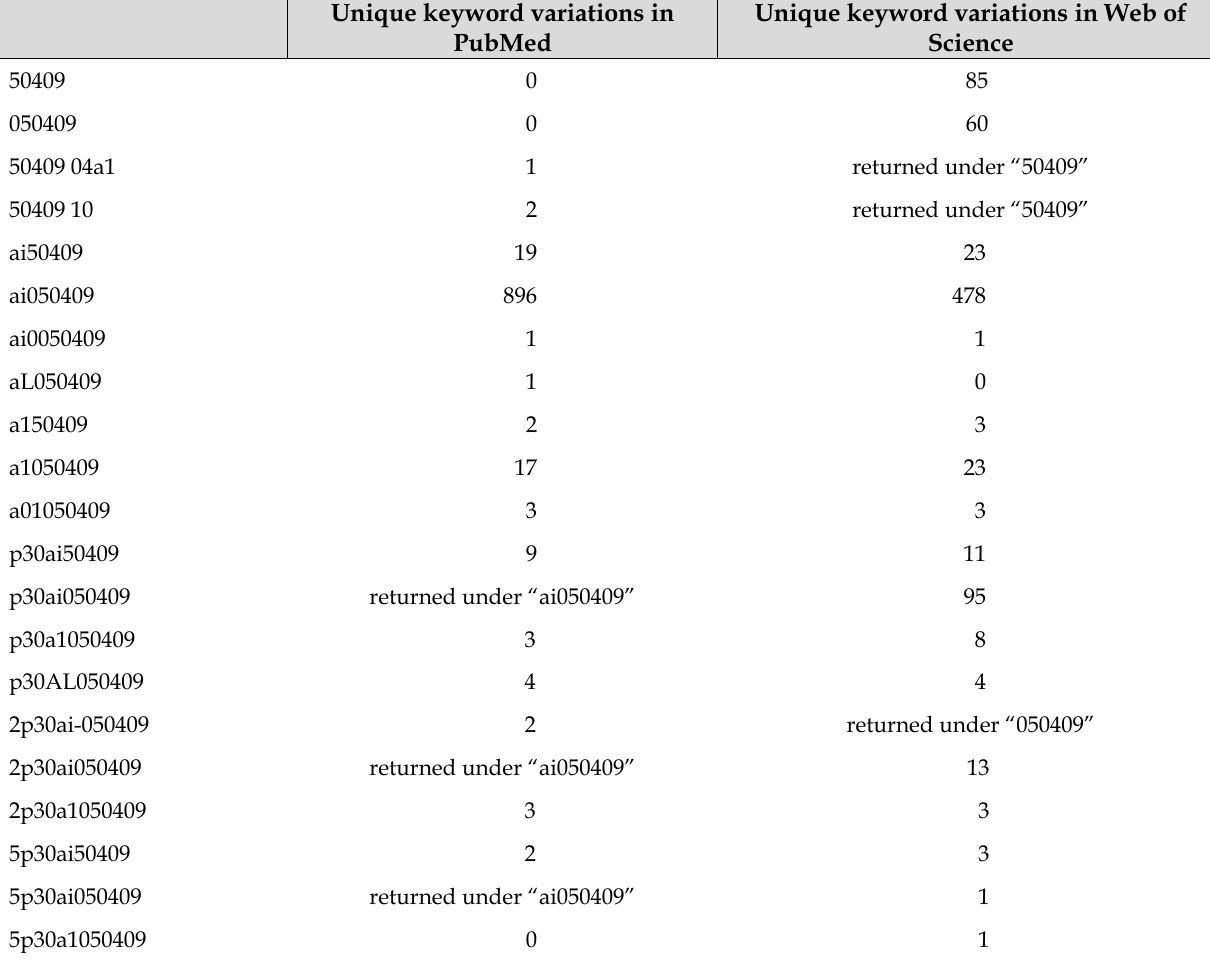
Web of Science returned unique results for all years, whereas PubMed returned unique results for only some